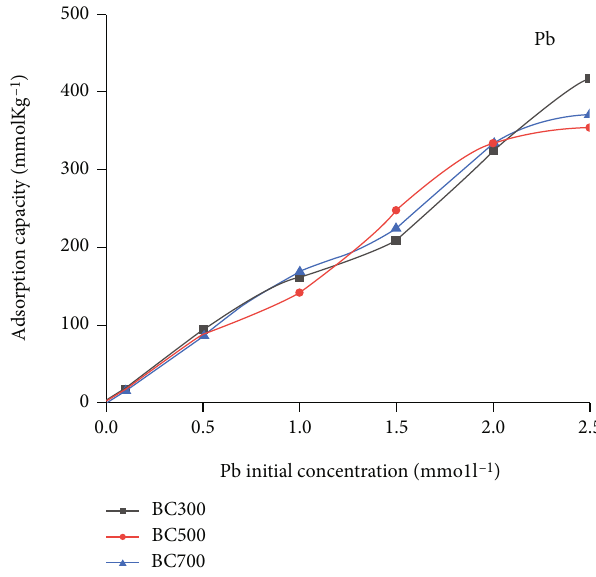
Figure 2: Adsorption rate of Pb 2+ in straw with di ff erent concentrations of heavy metal ions.